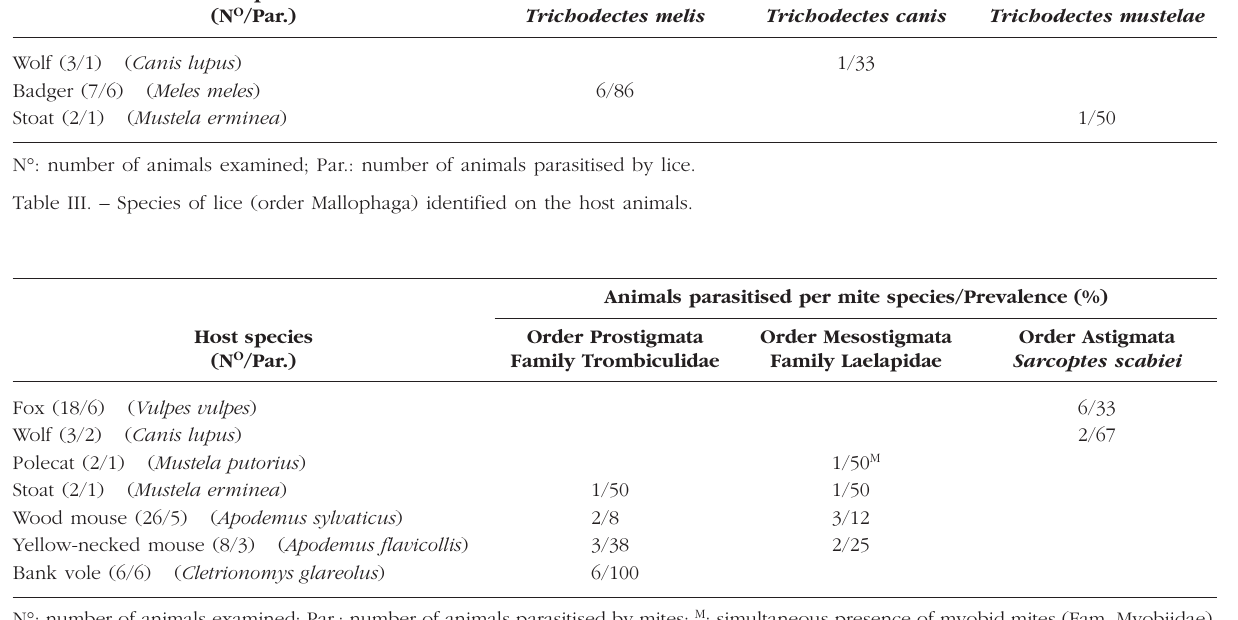
Table IV. – Species of mites identified on the host